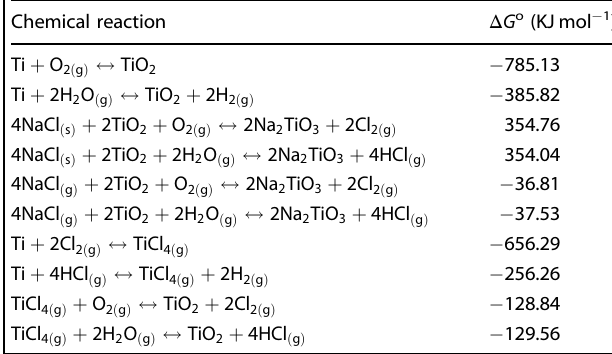
Table 1. The standard Gibbs free energy of the reactions at 600